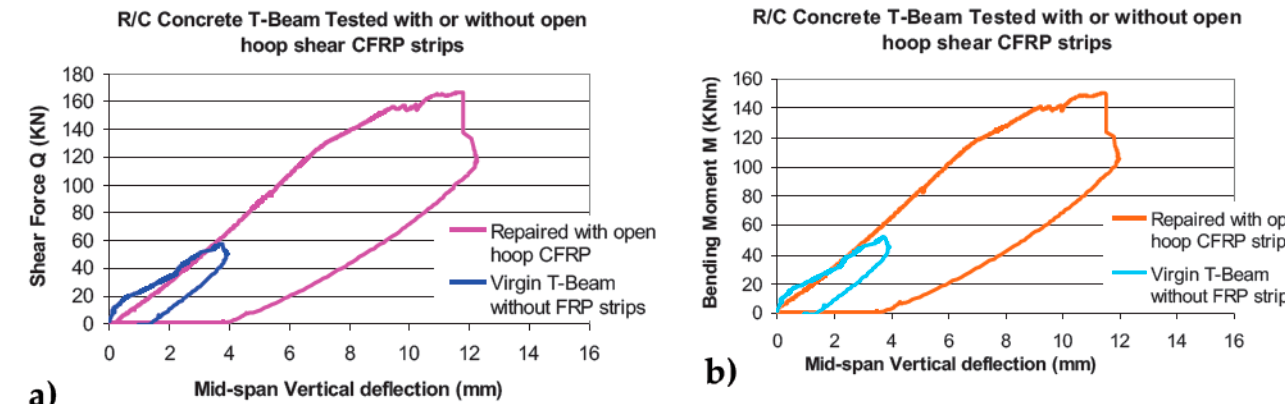
Figure 17. Comparison of failure modes between the prototype RC Virgin T-beam and this T-beam having been retrofitted with the 1st strengthening scheme. ( a ) Diagonal shear cracks at the East part of the Virgin T-beam. ( b ) The debonding of two open hoop CFRP strips without anchoring at the East part of this T-beam retrofitted with the 1 st st rengthening scheme .